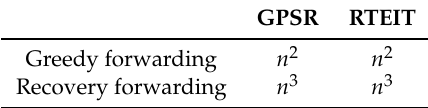
Table 2. Complexity comparison of GPSR and real-time effective information traffic routing (RTEIT).